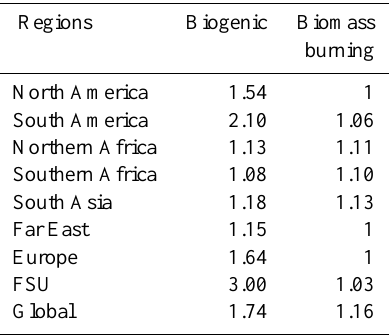
Table 4. Error reduction (ratio of the a priori to the a posteriori error) achieved by the OptS2 optimization calculated annually per source category and